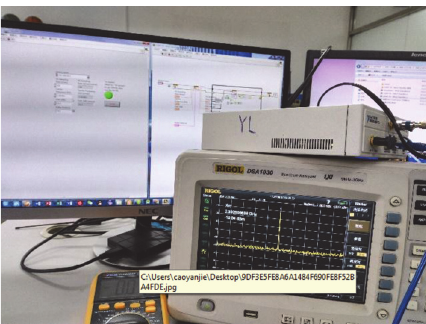
Figure 15: Experimental setups: an USRP is used to generate signal for the MPT system, the frequency and power of signal are controlled by programming on development platform Labview, and the power of signal is calibrated with spectrum analyzer.